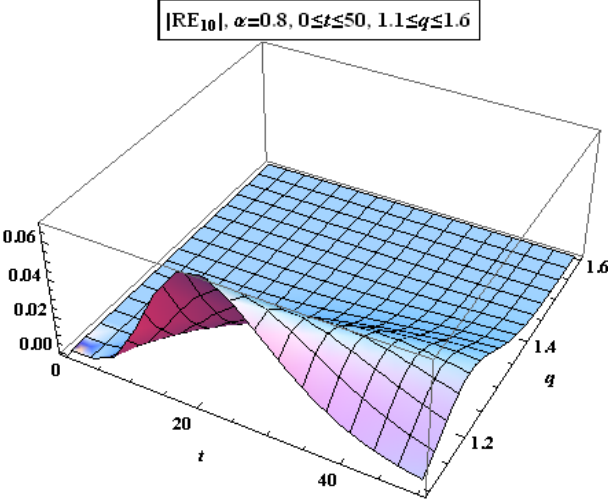
Figure 5. Residual at α = 0.8, λ = 1, 1.1 ≤ q ≤ 1.6.